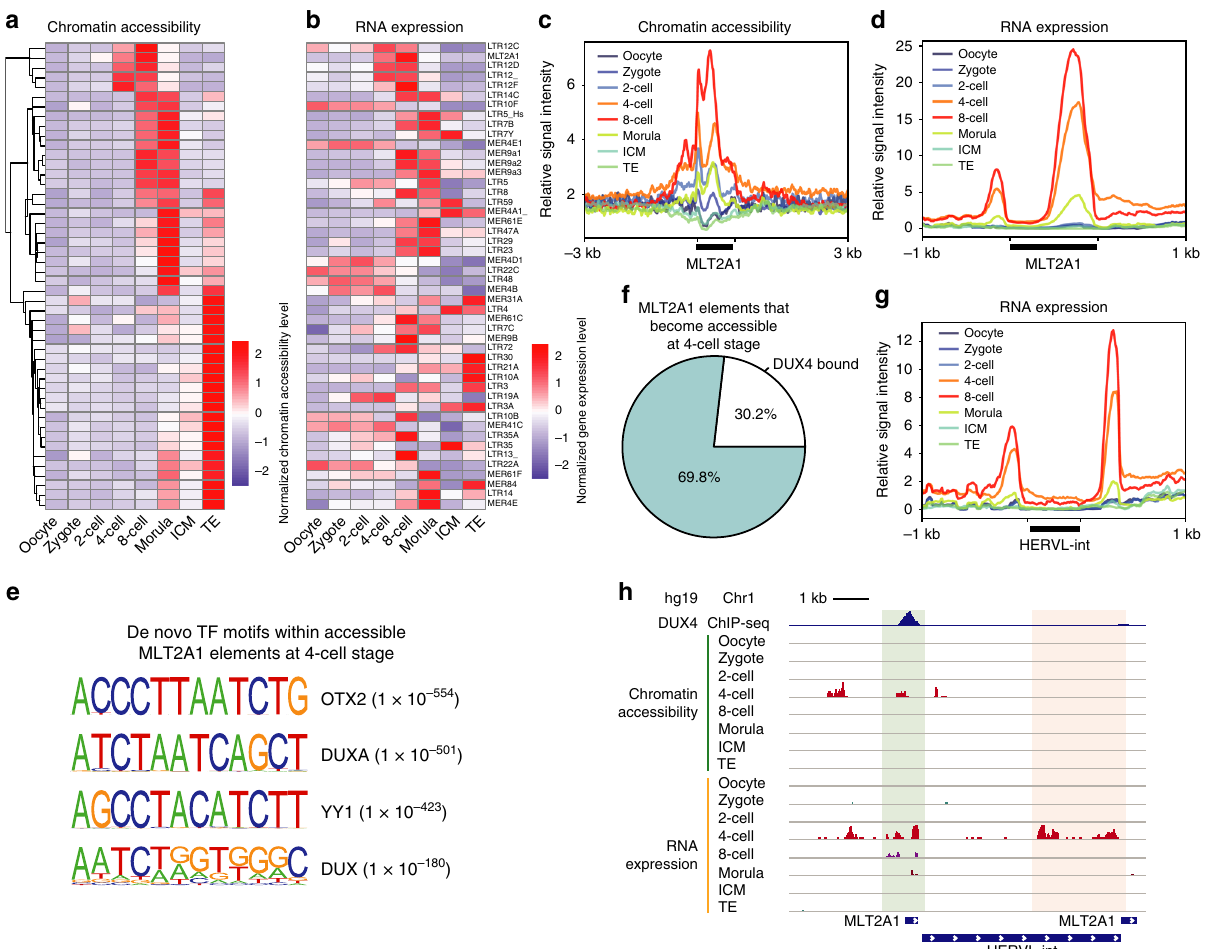
Fig. 4 Chromatin accessibility and expression dynamics of retrotransposons during human pre-implantation development. a , b Heat maps showing chromatin accessibility a and expression b levels of retrotransposons at the indicated development stages. c , d Chromatin accessibility c and RNA d read enrichment around MLT2A1 elements at the indicated stages. e Enrichment of the indicated transcription factor motifs found within MLT2A1 elements that become accessible at the 4-cell stage. f Proportion of MLT2A1 elements that are bound by DUX4 within all MLT2A1 elements that become accessible at the 4-cell stage. g RNA read enrichment around HERVL elements at the indicated stages. h Genome browser views showing DUX4 binding, chromatin accessibility, and gene expression signal around a HERVL element fl anked by MLT2A1. Source data used in this fi gure are provided as